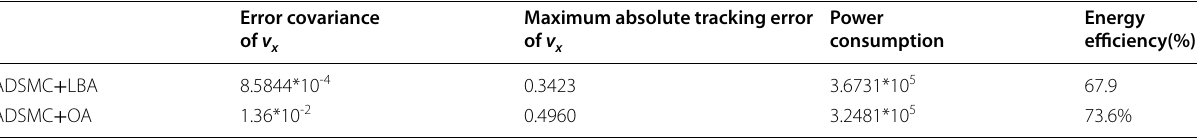
Table 3 Performances under different allocation